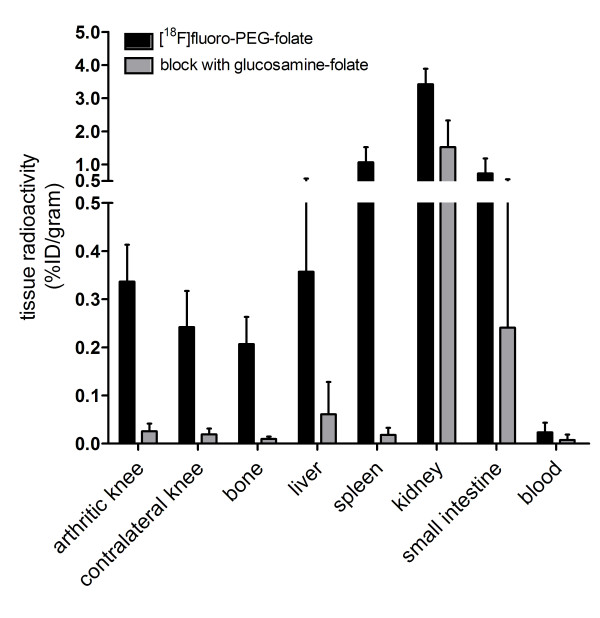
Tissue distribution of [18F]fluoro-PEG-folate. Tissue distribution of [18F]fluoro-PEG-folate in arthritic rats without (black bars) and with (gray bars) pre-treatment with a ≥100-fold molar excess of glucosamine-folate. Results are presented as mean ± SD of four untreated and four pre-treated rats.